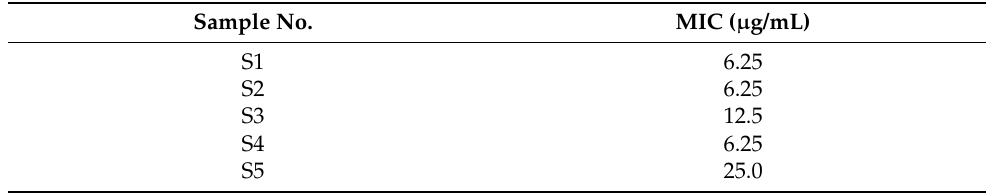
Table 3. The minimum inhibitory concentration (MIC) of various propolis types.